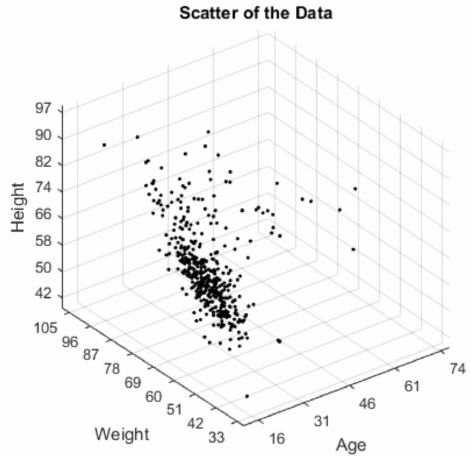
Figure 1. Scatter plot of the data of the subjects with age, weight and height parameters. In the data tibial rotation values of each subject were given as right tibial external rotation (RTER), right tibial internal rotation (RTIR), left tibial external rotation (LTER), left tibial internal rotation (LTIR) as seen in Figure 2. Totally, for every subject, it was 7 parameters as 3 of them are physical factors (age, weight and height) and 4 of them are tibial rotation values (RTER, RTIR, LTER and LTIR). The physical parameters are input and the rotation values are